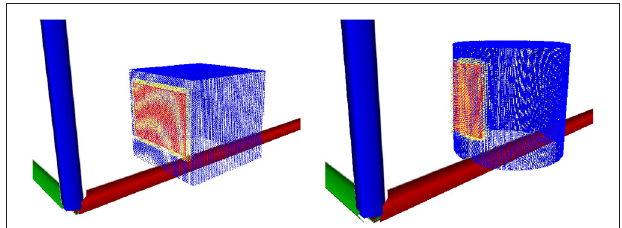
FIGURE 3 | Visualisation of the contact models of a cube and cylinder. Blue is the point cloud, yellow are the contacts in the model and red are the projections of the contacts onto the robot’s